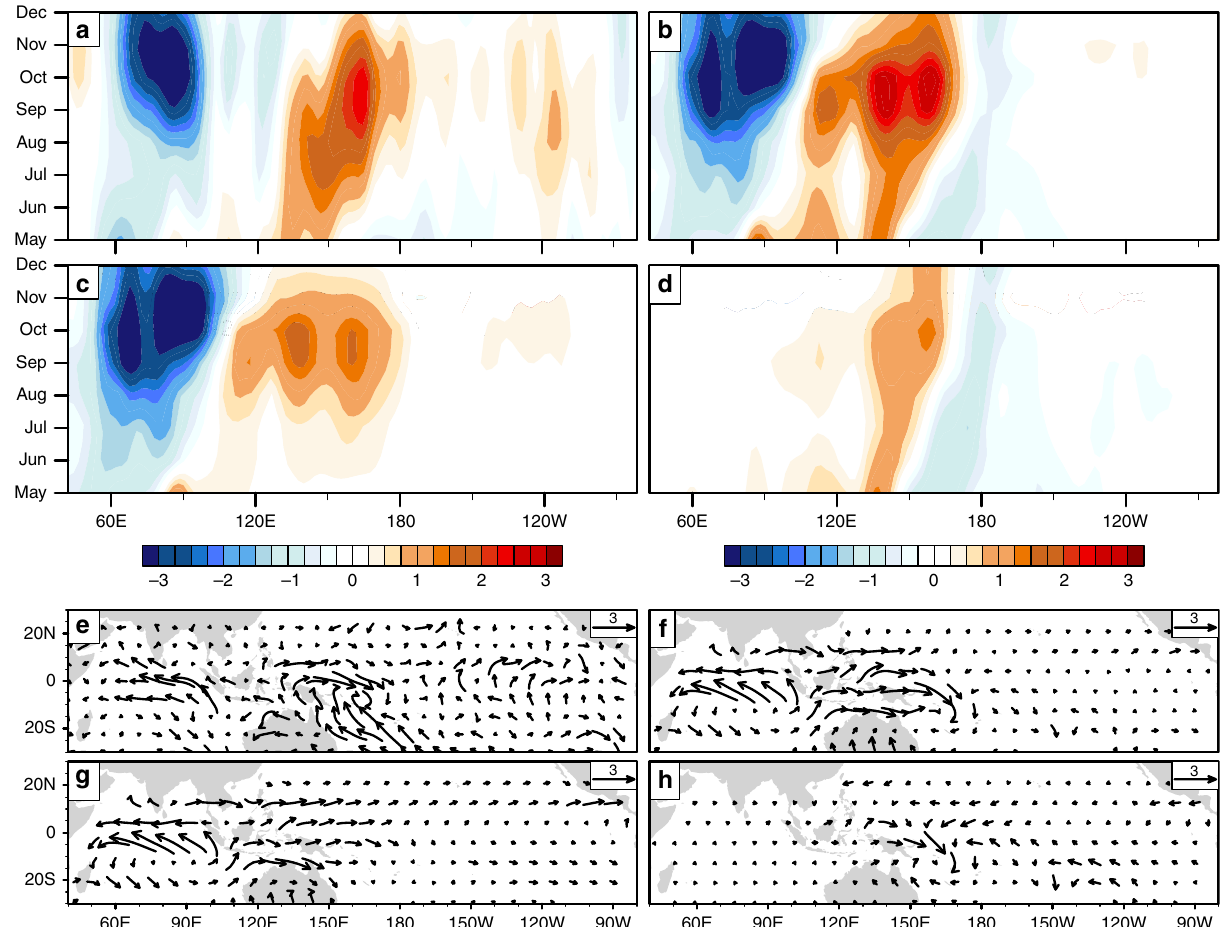
Fig. 7 Simulation of monthly tropical surface wind anomalies during 2006. a – d Longitude time evolution of monthly equatorial zonal wind anomalies from observations ( a ) and numerical experiments ( b – d ). In the control experiment shown in b , the atmospheric model was forced with diabatic heating anomalies over the tropics covering the Indian and Paci fi c Oceans. In a sensitivity experiment, the forcing was prescribed only over the Indian ( c ), and in another, the forcing was prescribed only over the Paci fi c Ocean ( d ). e – h Surface wind anomalies, averaged between July and October, for the observations ( e ) and the numerical experiments ( f – h ); here, f is the control experiment, and g and h are the counterparts of c and d above. Comparing the surface wind anomalies from g against that from f , we estimated that the Indian Ocean forcing alone accounted for 84% of the anomalous zonal westerly amplitude over the equatorial western Paci fi c (160°E – 170°W). While the Paci fi c convection also contributes a minor amount, oppositely signed surface wind anomalies to its west and east ( h ) weaken the the impact of these winds on the eastern-ocean. All the data were lightly smoothed with a 3-month running mean fi lter. The maps in the fi gure were rendered with the NCAR Command Language software (https://doi.org/10.5065/D6WD3XH5) from the Global Self- consistent, Hierarchical, High-resolution Geography Database (GSHHG). The GSHHG is available online at https://www.ngdc.noaa.gov/mgg/shorelines/